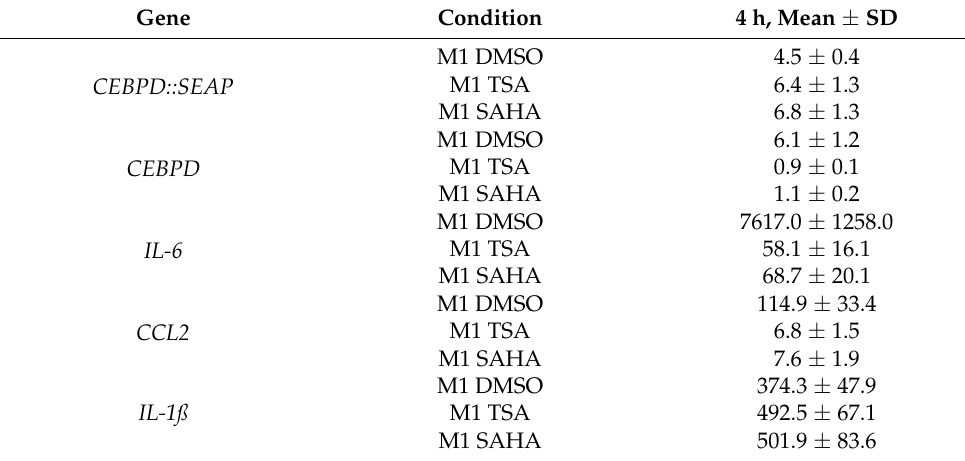
Table 4. Fold change (mean ± SD) for mRNA expression in SAHA-pre-treated and TSA-pre-treated target cells compared to M0 controls ( compare Figure